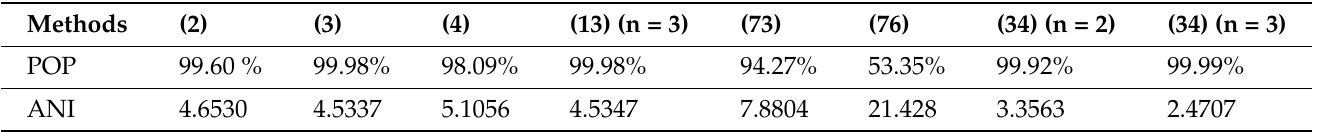
Table 5. Numerical results of different methods for z 6 − 1 =